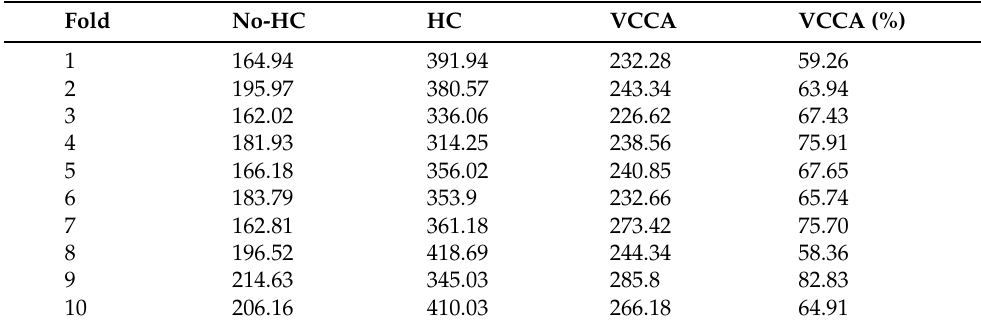
Table 17. The training times in seconds for Dataset